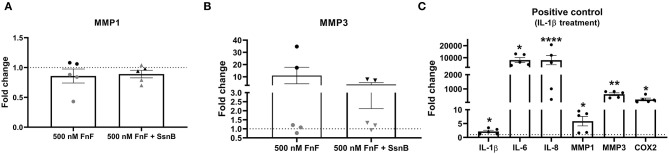
Gene expression of MMP-1 (A) and MMP-3 (B) after 18 h exposure to 30 kDa fibronectin fragments (500nM) alone and in combination with the TRL-2/TRL-4 inhibitor Sparstolonin B. Gene expression of IL-1β, IL-6, IL-8, COX-2, MMP-1, and MMP-3 after 8h exposure to canine IL-1β (C). mRNA was quantified by real time RT-qPCR (RT-qPCR). Values of MMP-1 and MMP-3 were normalized to the reference gene (GAPDH) and presented as the fold change compared to untreated control (FnF stimulation alone) or NP cells treated with Sparstolonin B alone (A,B). Values of IL-1β, IL-6, IL-8, MMP-1, MMP-3, and COX-2 were normalized to the reference gene (GAPDH) and presented as the fold change compared between IL-1β treatment and untreated controls (C). *Denotes statistically significant differences with p < 0.05. Points demonstrate NP-cells treated with 500nM 30kDa FnF. Triangles demonstrate NP cells treated with a combination of FnF and Sparstolonin B. The color black indicates high responders and the color gray indicates low responders. *Denotes statistically significant differences with p < 0.05, **p < 0.01 and ****p < 0.0001.